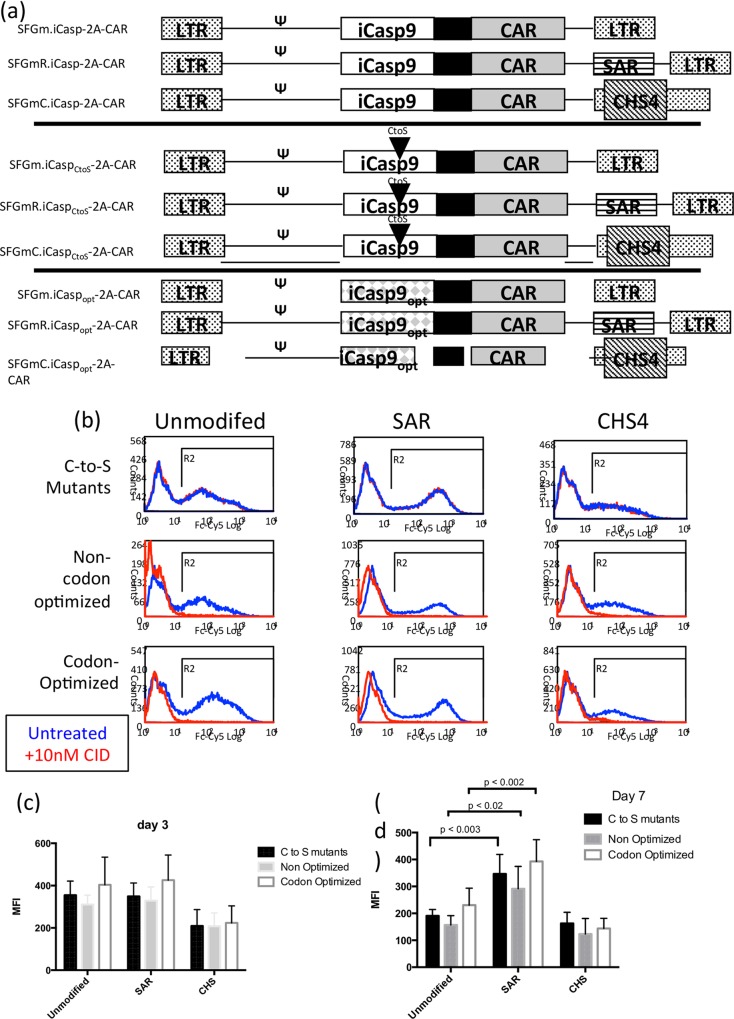
Optimization of expression cassette for co-expression with iCasp9.(a) Nine different expression cassettes were compared: Three different retroviral vectors were generated–wild-type SFG, SFG with scaffold-attachment region (SAR) inserted into the 3’UTR and SFG with CHS4 inserted into the 3’LTR U3 region. (retroviral vectors with both SAR and CHS4 were generated but produced very low vector titers and were not compared further); Into these retroviral vectors wild-type iCasp9-2A-huK666 CAR constructs were inserted and iCasp9 were inserted in 3 forms; codon-optimized, wild-type, and with the catalytic domain mutated. (b) Histogrammes at day 3 after transduction (blue lines). Overlaid T-cells cultured in 20nM CID are shown in red. Bargraphs of MFI of cells in the absence of CID at day 3 (c) and (d) day 7. Data shown as means +/-SEM from 5 independent experiments with different donors.